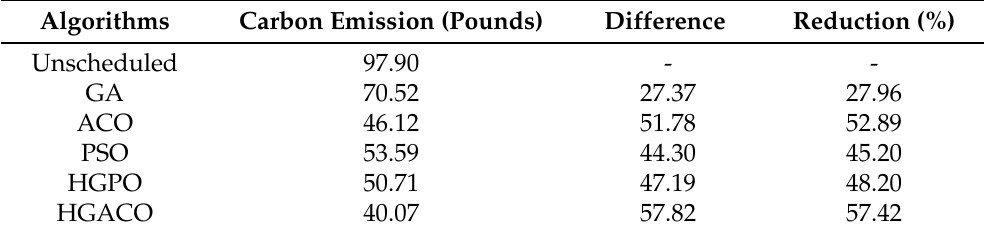
Table 14. Scenario III: carbon emission assessment with photovoltaic-battery